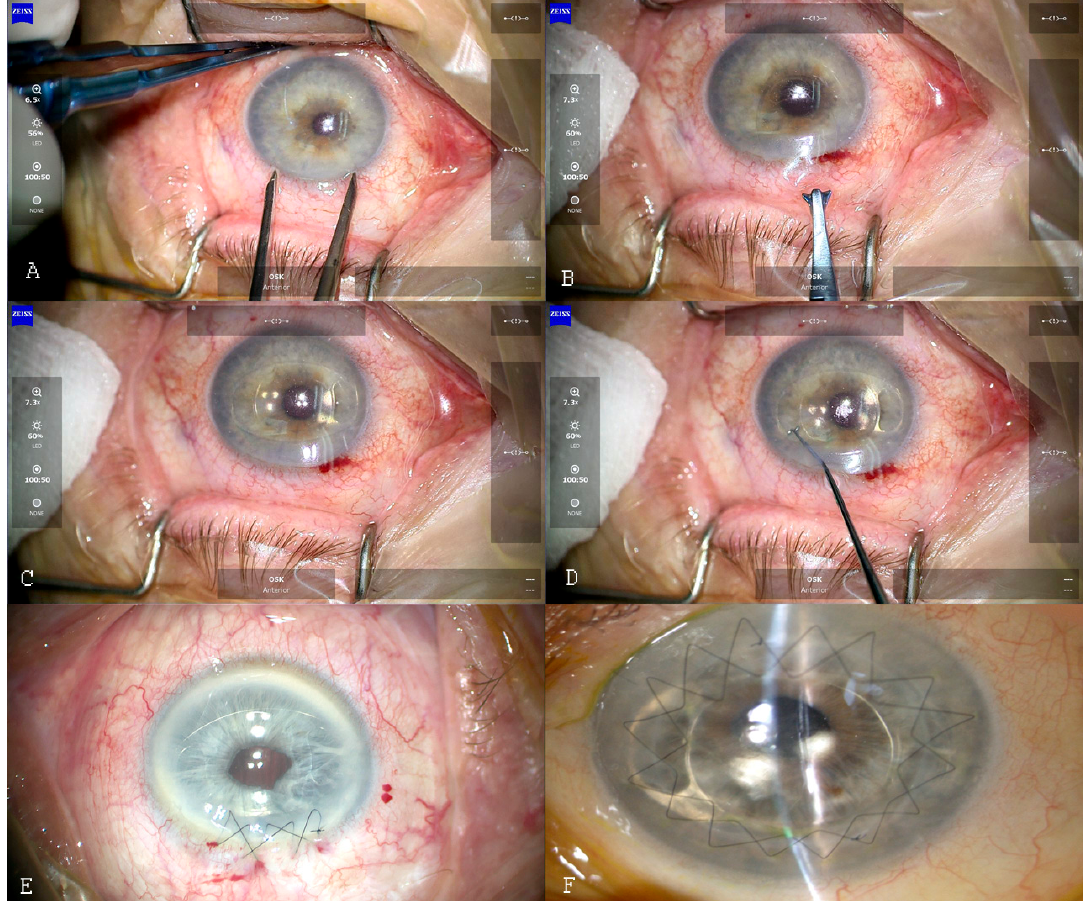
Figure 1. Iris-claw Artisan IOL (Artisan Aphakia IOL model 205, Ophtec BV) implantation technique: ( A ) paracenteses and corneal incision placement, ( B ) inserting the IOL into the anterior chamber, ( C ) centering the IOL over the pupil, ( D ) fixing the haptics to the iris mid-periphery using the enclavation needle, ( E ) suturing the main corneal incision, ( F ) implantation combined with penetrating keratoplasty. Please see the detailed description in the text.